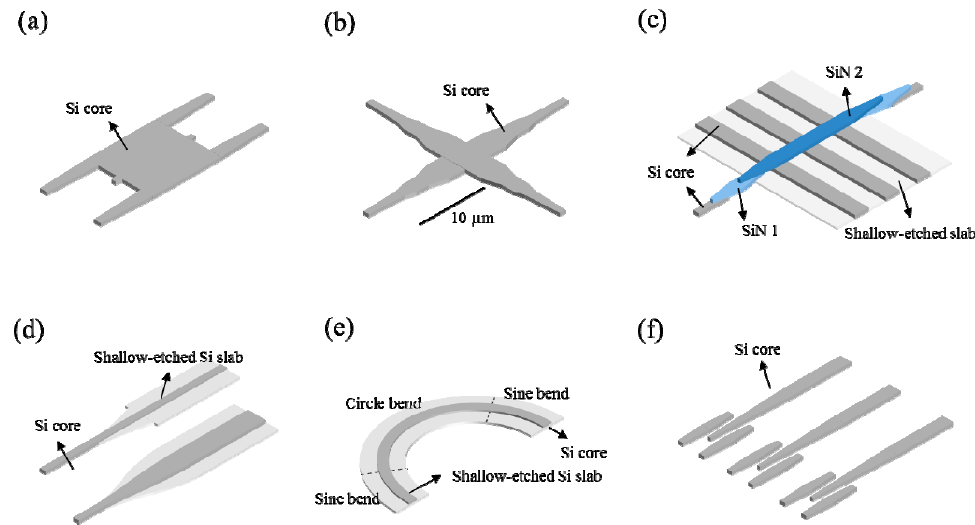
Figure 7. Passive components ( a ) MMI coupler ( b ) In-plane waveguide crossing ( c ) 3D waveguide crossing ( d ) transition waveguides ( e ) adiabatic bend waveguide ( f ) trident edge coupler array.